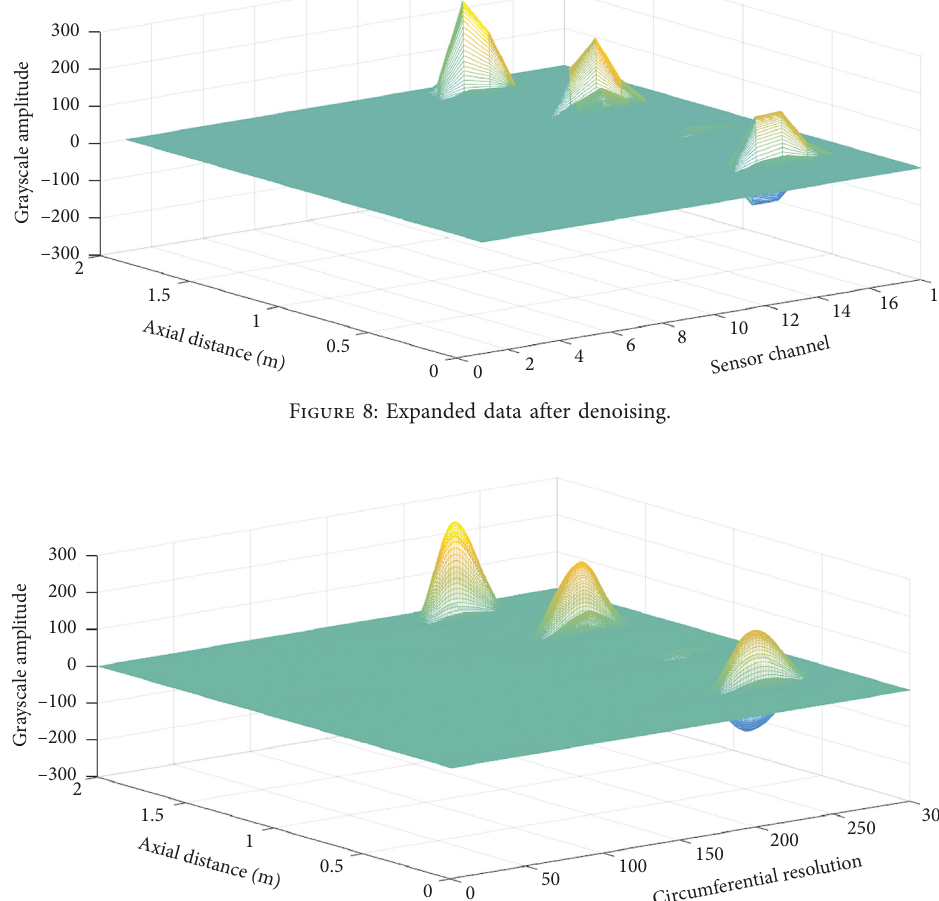
Figure 10: Grayscale image of MFL